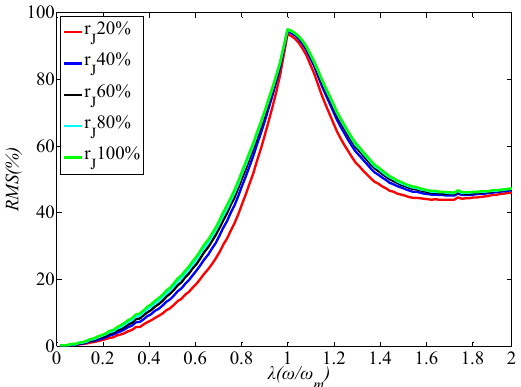
Figure 7. E ff ect of excitation frequency on control e ff ectiveness: curves of RMS Figure 7. Effect of excitation frequency on control effectiveness: curves of RMS .